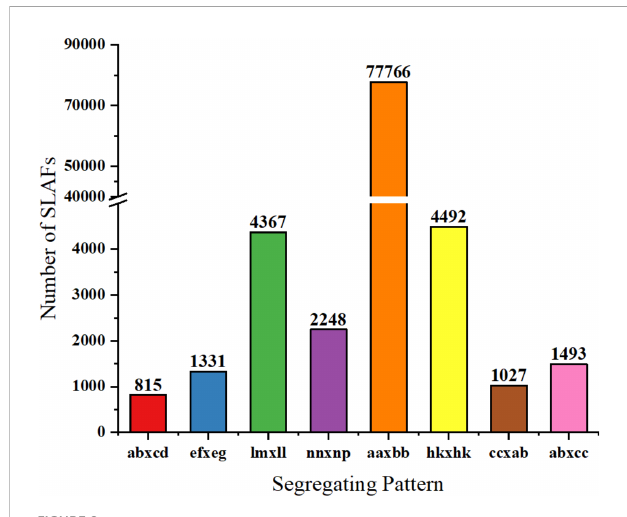
FIGURE 2 Genotype distribution of SLAF markers in onion. The Y-axis indicates the number of SLAF markers, x-axis indicates the segregation patterns of markers.